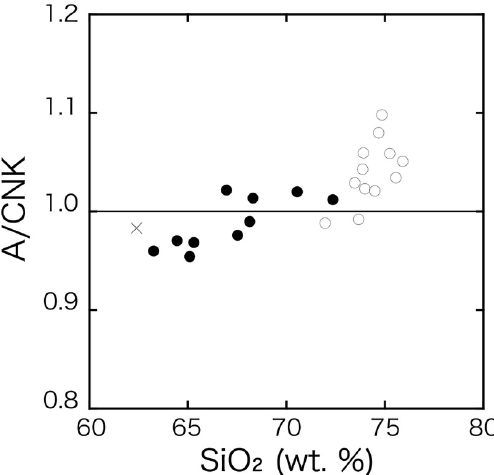
Figure 7. ASI-SiO 2 diagram for the rocks in the Hisakajima Island. A/CNK — molar Al 2 O 3 / (CaO + Na 2 O + K 2 O). Solid circles — GD group samples. Open circles — HFG group samples.Cross mark —